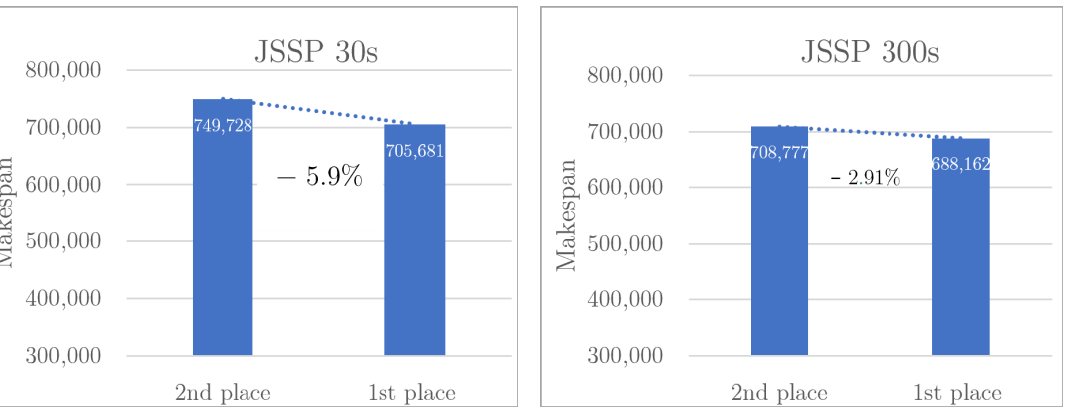
Figure 5. Makespan differences by algorithm selection per instance for JSSP.